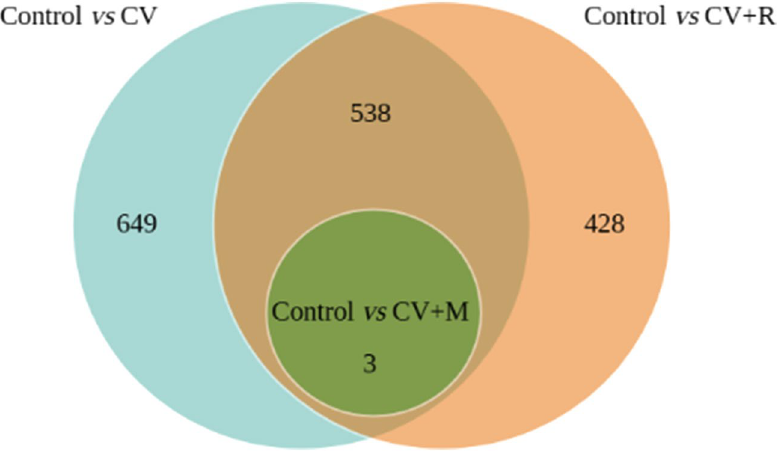
Figure 1. Venn diagram with the distribution of the DEGs in the three experimental diet